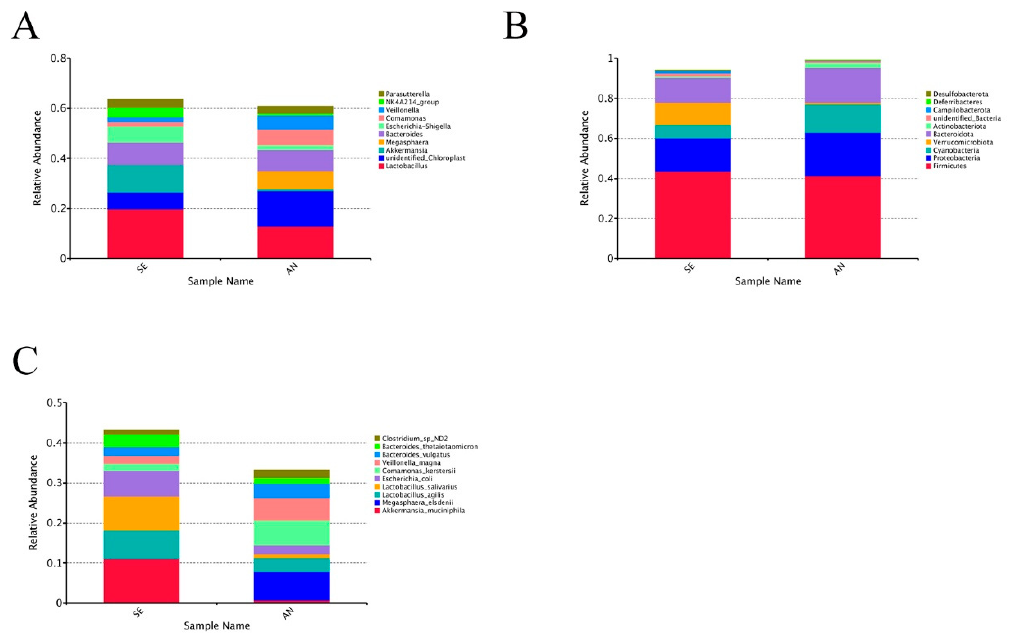
Figure 7. Distribution of the top bacterial communities in AN and SE samples at the phylum level ( A ), genus level ( B ), and the species level ( C ).